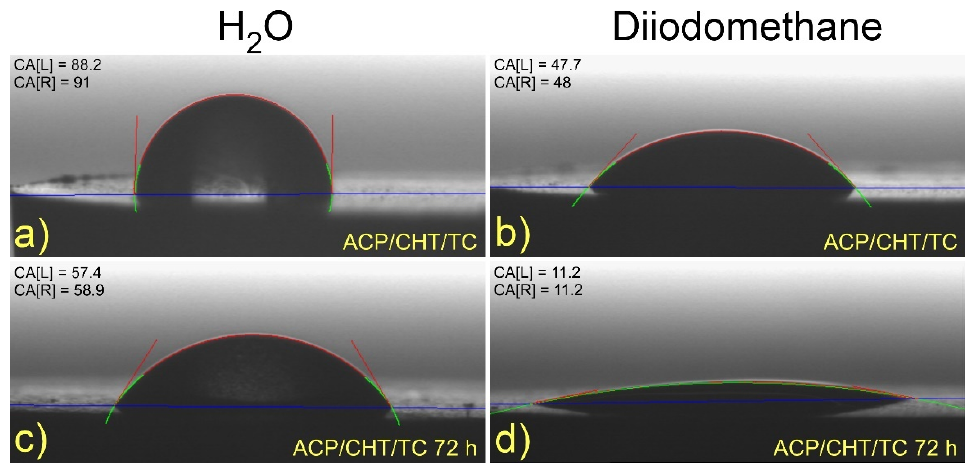
Figure 7. Typical images of ( a , c ) water and ( b , d ) diiodomethane droplets on as-deposited composites films ( a , b ) and after 72 h of degradation in SBF ( c , d ).